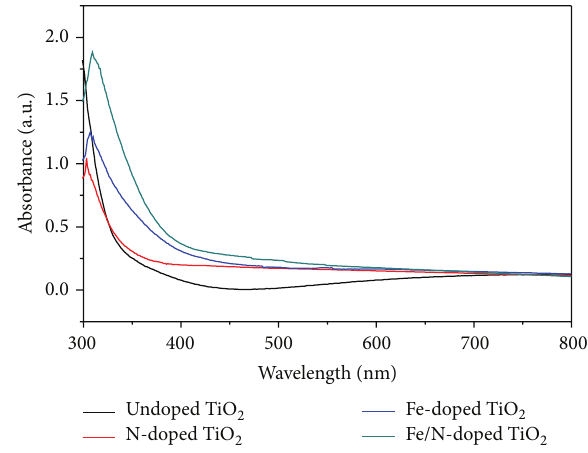
Figure 2: XRD spectra of TiO 2 catalysts.